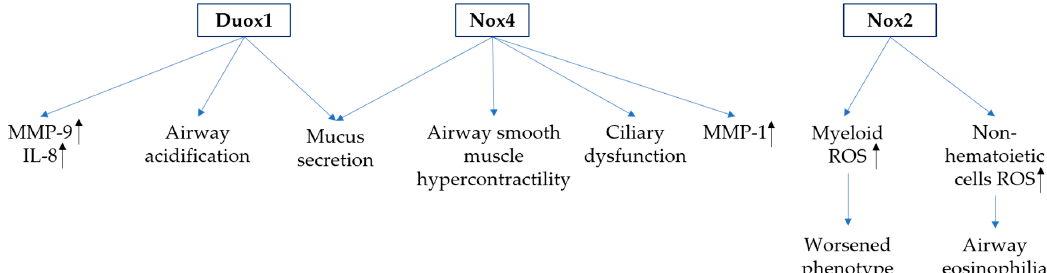
Figure 2. Role of Nox in asthma. Nox2, Nox4 and dual oxidase 1 (Duox1) play critical roles in asthma through various mechanisms. Both Duox1 and Nox4 stimulate mucus secretion and matrix metalloprotease (MMP) production in airway epithelial cells. In addition, Nuox1 enhances airway acidification and Nox4 induces ciliary dysfunction and airway smooth muscle hypercontractility. Nox2 expressed in myeloid and non-hematoietic cells plays distinctive roles in asthma. Nox2 expressed in myeloid cells is believed to mediate the worsened phenotype of asthma, while Nox2 expressed in the lung structure cells mediates airway